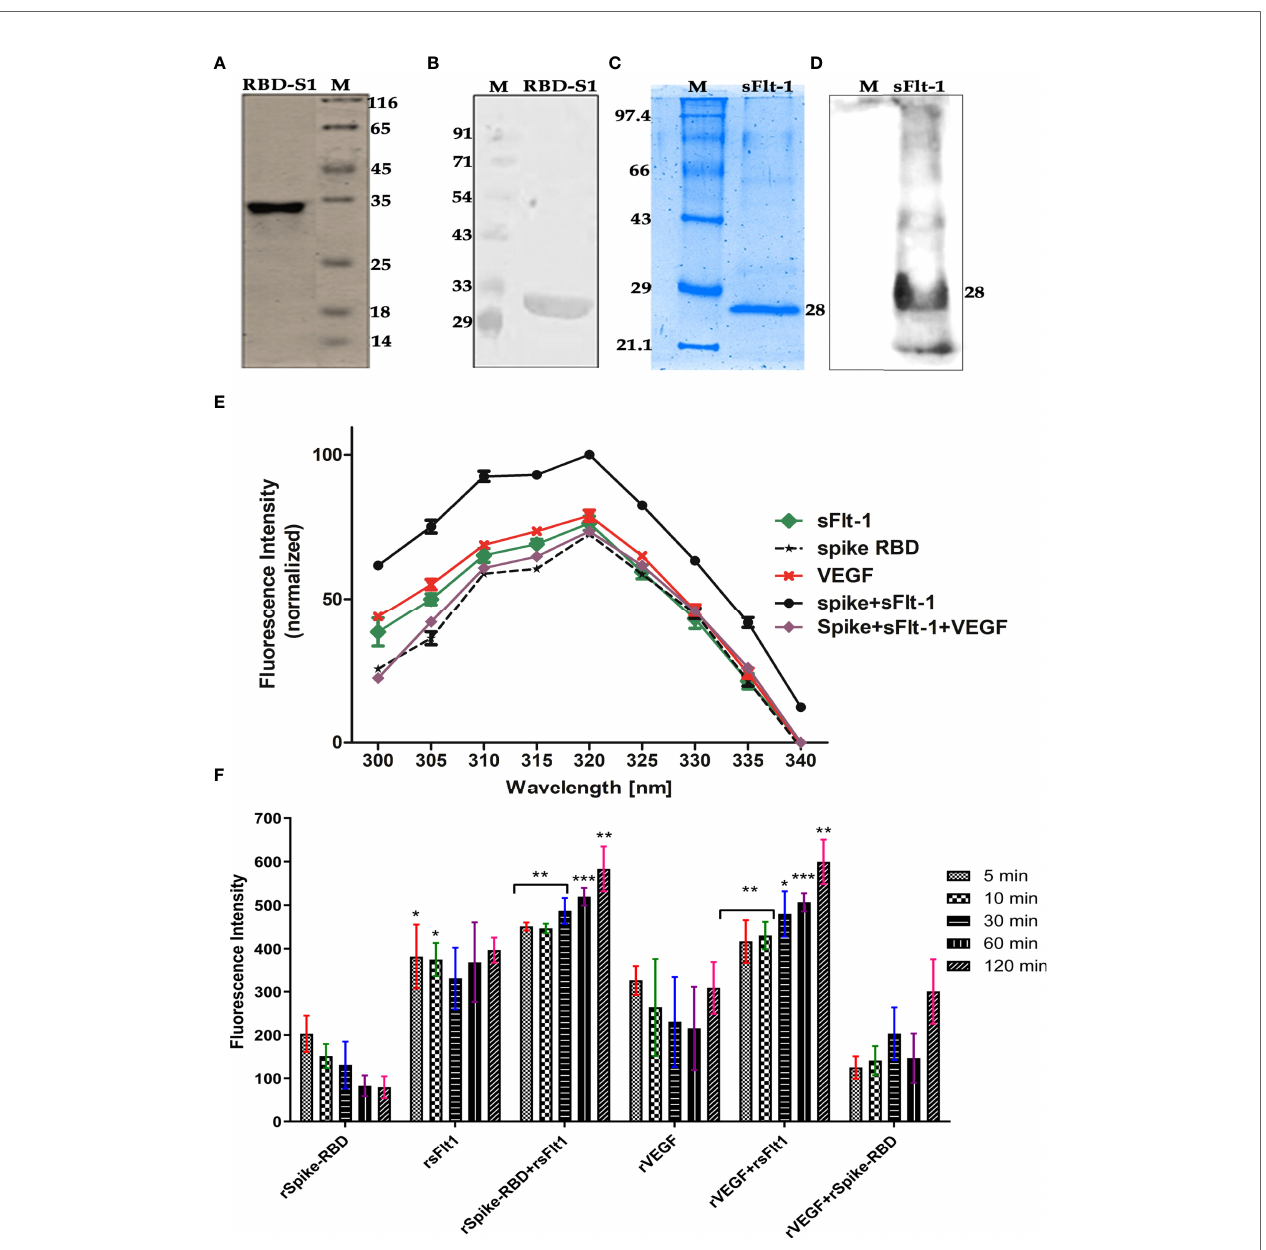
FIGURE 3 | (A – D) Con fi rmation of puri fi ed rspike RBD and rsFlt1 proteins by SDS-PAGE and western blotting. (A) Silver-stained gel image of puri fi ed His − tagged recombinant SARS − CoV − 2 spike (RBD-S1) protein; Lane (1) rspike RBD protein, Lane (2) Unstained Protein Molecular Weight Marker. (B) Western blot image of puri fi ed rspike RBD-S1 Protein; Lane (1) Pre-stained protein molecular weight marker, Lane (2) rspike RBD protein with molecular weight of ~33 Kda. (C) Coomassie brilliant blue stained gel of puri fi ed rsFlt-1; Lane (1) Unstained protein molecular weight marker. Lane (2) rsFlt-1. (D) rsFlt-1 puri fi cation con fi rmed on western blot; Lane (1) pre-stained protein molecular weight marker, Lane (2) rsFlt-1 protein with molecular weight of 28Kda. M denotes for molecular weight marker (E) Fluorescence scan of intrinsic amino acids revealed rspike RBD+rsFlt-1 interaction with highest fl uorescence intensity, VEGF, anti-Flt-1 antibody and anti-spike RBD antibody used as competitors or inhibitors of the interaction respectively, Error bars too small and data represented as Mean ± SEM. (n=3). (F) The fl uorescence intensity of rSpike RBD/sFlt-1 alone or in combination showing protein-protein interactions at time-dependent manner based on the fl uorescent aromatic amino acids, rVEGF-rsFlt-1 or rVEGF-rspike RBD are positive and negative controls respectively. The fl uorescence emission by rspike RBD-rsFlt-1 or rVEGF-rsFlt-1 complexes was comparatively higher than the fl uorescence emitted by rSpike RBD, rsFlt-1, or rVEGF alone. Statistical test for normal distribution was conducted by D ’ Agostino & Pearson test and Anderson-Darling test conforms normal distribution. Further two-way ANOVA (parametric) using Dunnett ’ s multiple comparisons test was chosen for multiple comparisons between spike RBD+sFlt-1 and spike RBD +sFlt-1 + VEGF revealed a signi fi cant difference (P<0.0001). In Panel F, Shapiro-Wilk test was applied for the normal distribution test and con fi rms the normality of the data, two-way ANOVA by Dunnett ’ s multiple comparisons test, was further used for the comparison of multiple groups. P-values indicates statistical signi fi cance compared to control groups (*P<0.05, ** P<0.01, ***